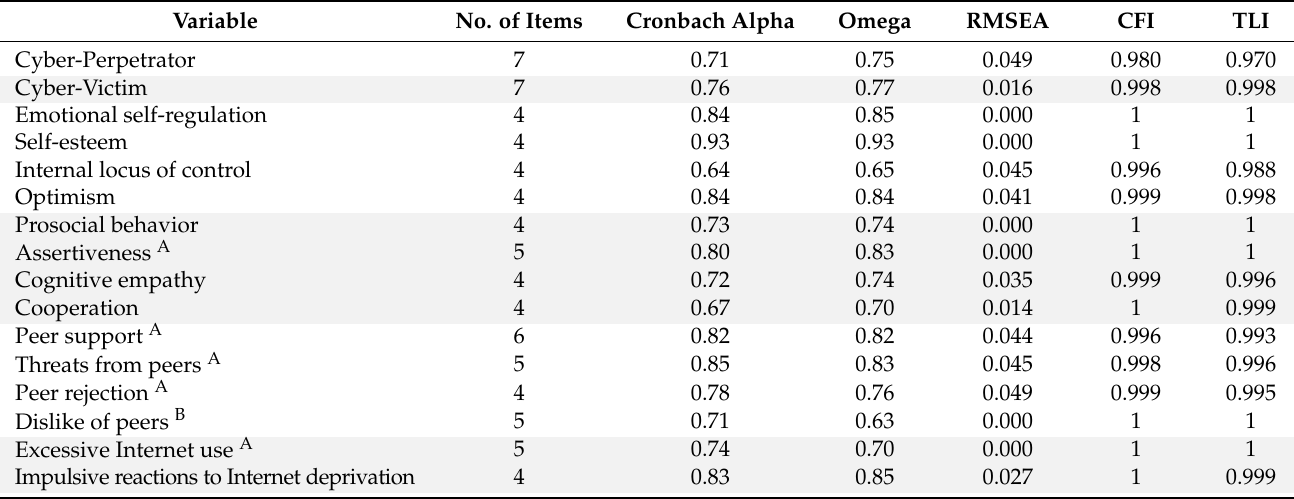
Table 2. Reliability and model fit